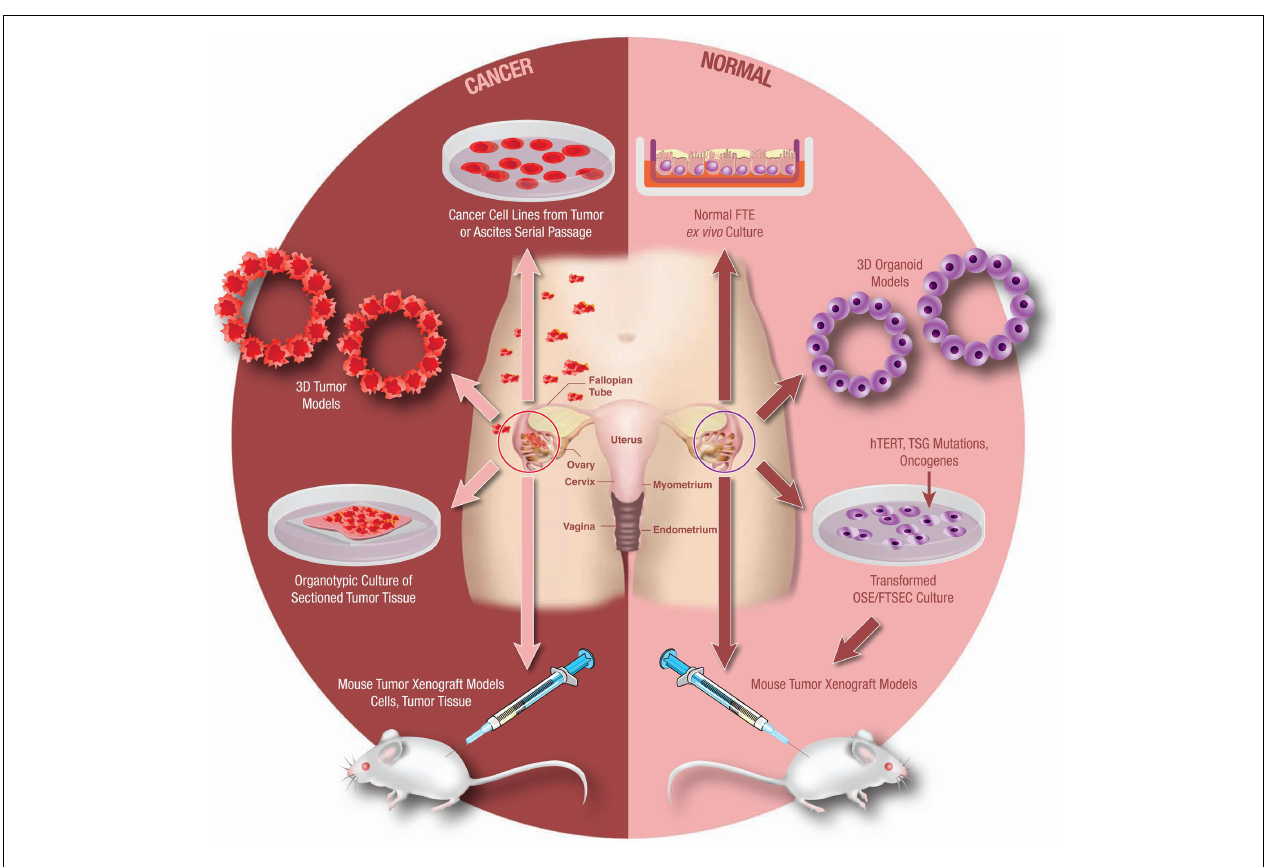
two-dimensional (2D) cell culture into 3D and organoid cultures has yielded important insights into the biology of this disease, as has the development of unique animal models. Development of these models is critical as our understanding of this cancer continues to